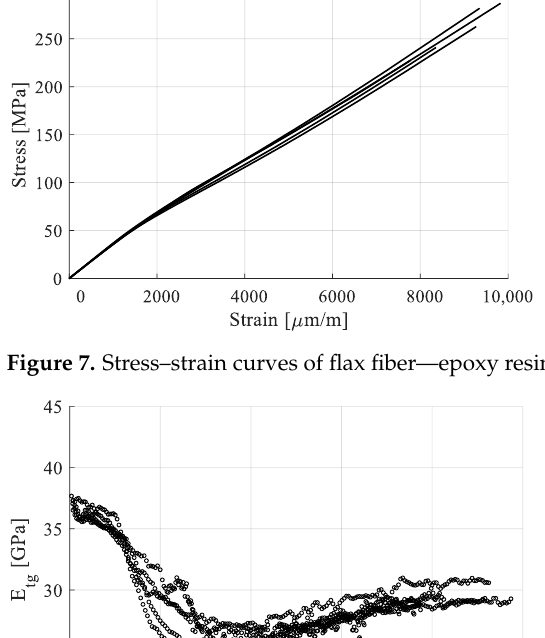
Figure 8. Tangent modulus with respect to strain. Figure 9. Detail on the calculus of 𝜎 𝑦 . Table 3. Calculated mechanical properties of the flax fiber — epoxy resin composite.